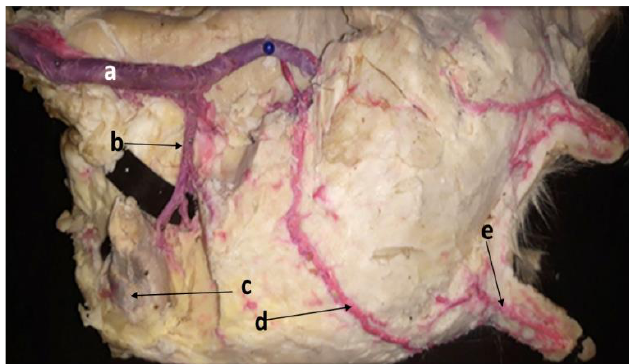
Figure 3. Photograph of u dder of local Iraqi cow with injected blood vessels shows: (a) External pudendal artery, (b) Branch of